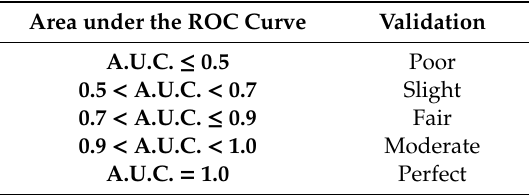
Table 4. Values proposed by Landis and Koch